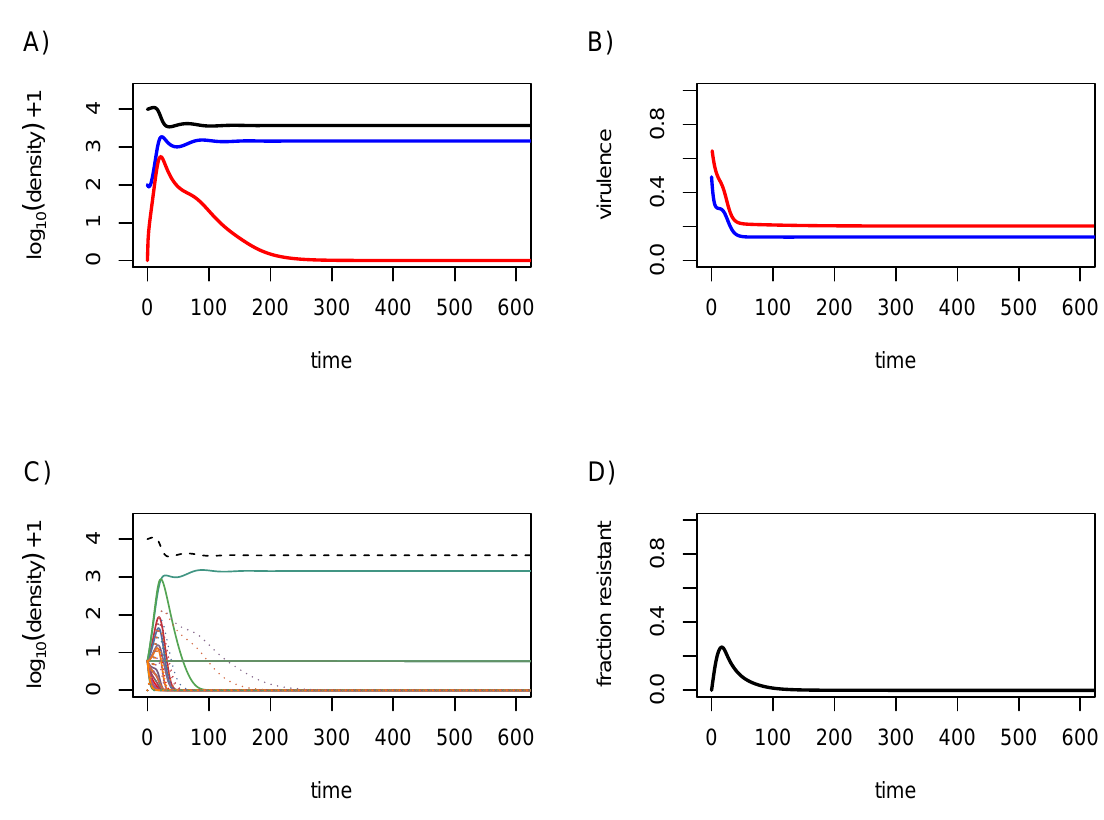
Figure S2 – Long-term evolutionary dynamics. Even with the same parameter values as in the main text, drug-sensitive infections can eventually dominate the system. This is because we only have a limited number of strains in the simulations. Parameter values are the same as in the main text but the n = 20 strains are different (although drawn using the same covariance matrix as in the main